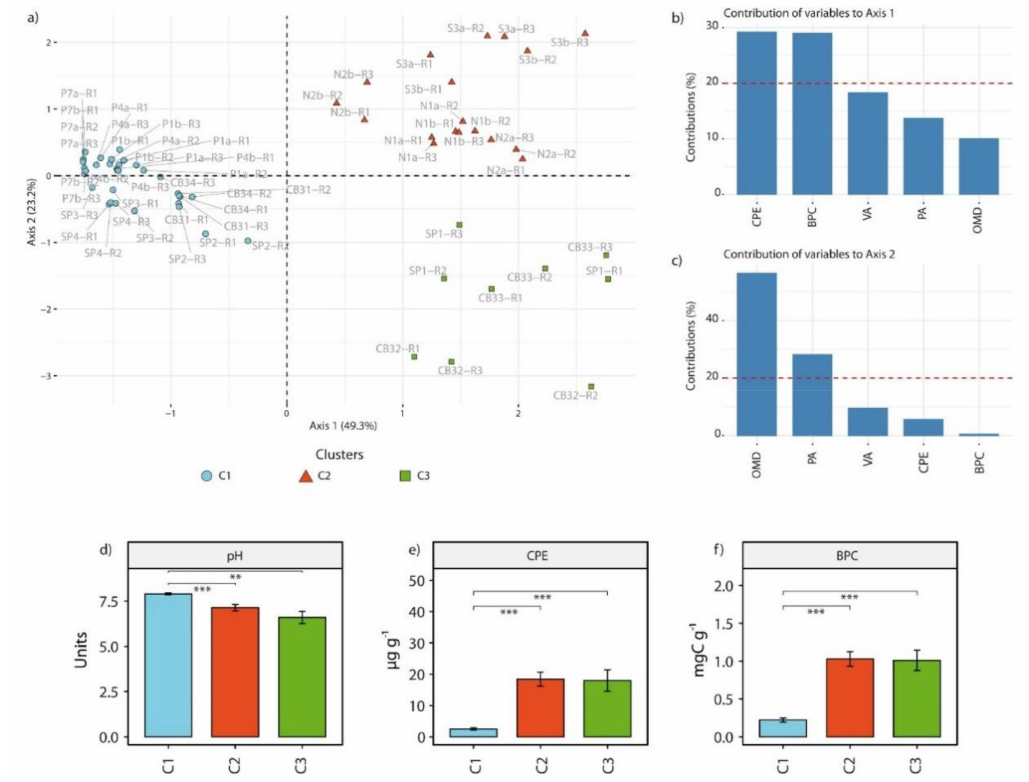
Figure 1. Results of k-means clustering and PCA carried out on biotic variables analyzed across all sites. ( a ) PCA plot showing the distribution of samples in a two-dimensional space, with the amount of variance explained by each axis and affiliation of sampling points to each cluster. ( b ) Contribution of the 5 variables analyzed to the variance explained by axis 1, ( c ) contribution of the 5 variables analyzed to the variance explained by axis 2, ( d – f ) histograms showing the average values for pH, chlorophyll pigments equivalents and biopolymeric C concentrations among the 3 clusters identified, with asterisks displaying significant differences between clusters (** for p -values < 0.01, *** for p -values < 0.001) and error bars computed on the standard error for each cluster. PA: prokaryotic abundances (cell g − 1 ); VA: viral abundances (viruses g − 1 ); BPC: biopolymeric C concentration (mgC g − 1 ); CPE: chlorophyll pigment equivalents ( µ g g − 1 ); OMT: organic matter turnover ( µ gC g − 1 h − 1 ).